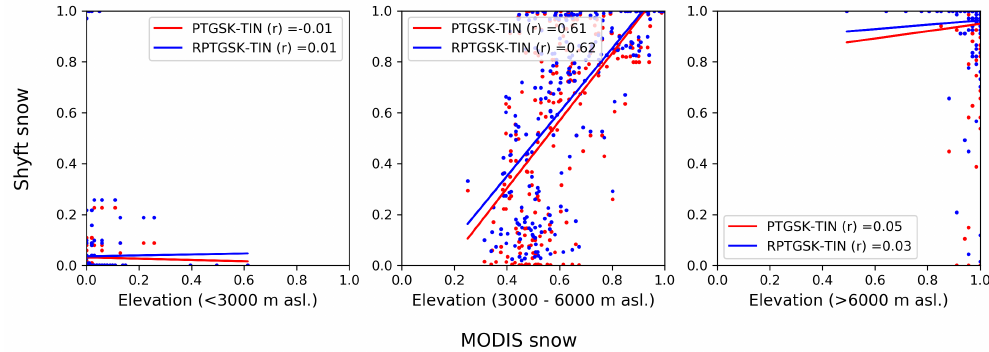
Figure 10. Scatterplot between MODIS derived snow and models (PTGSK-TIN and RPTGSK-TIN) for each altitudinal zone. In each plot “r” represent correlation coefficient.